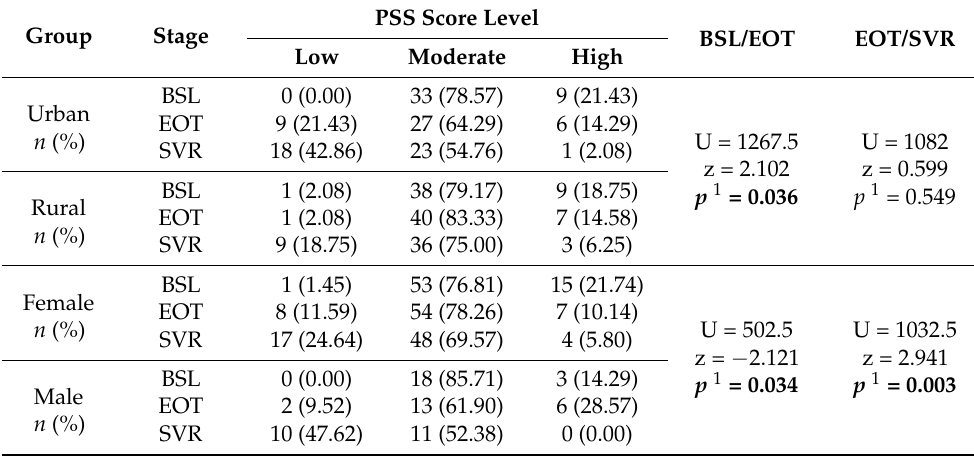
Table 3. The levels of perceived stress (PSS) correlated with the demographic characteristics of the study